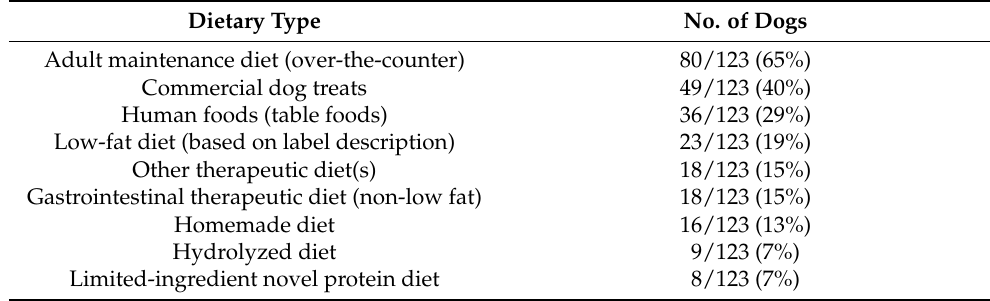
Table 6. Pre-existing diets reported in survey data from dogs with a serum cPLI concentration ≥ 400 µ g/L. Note: some dogs did receive more than one diet type.